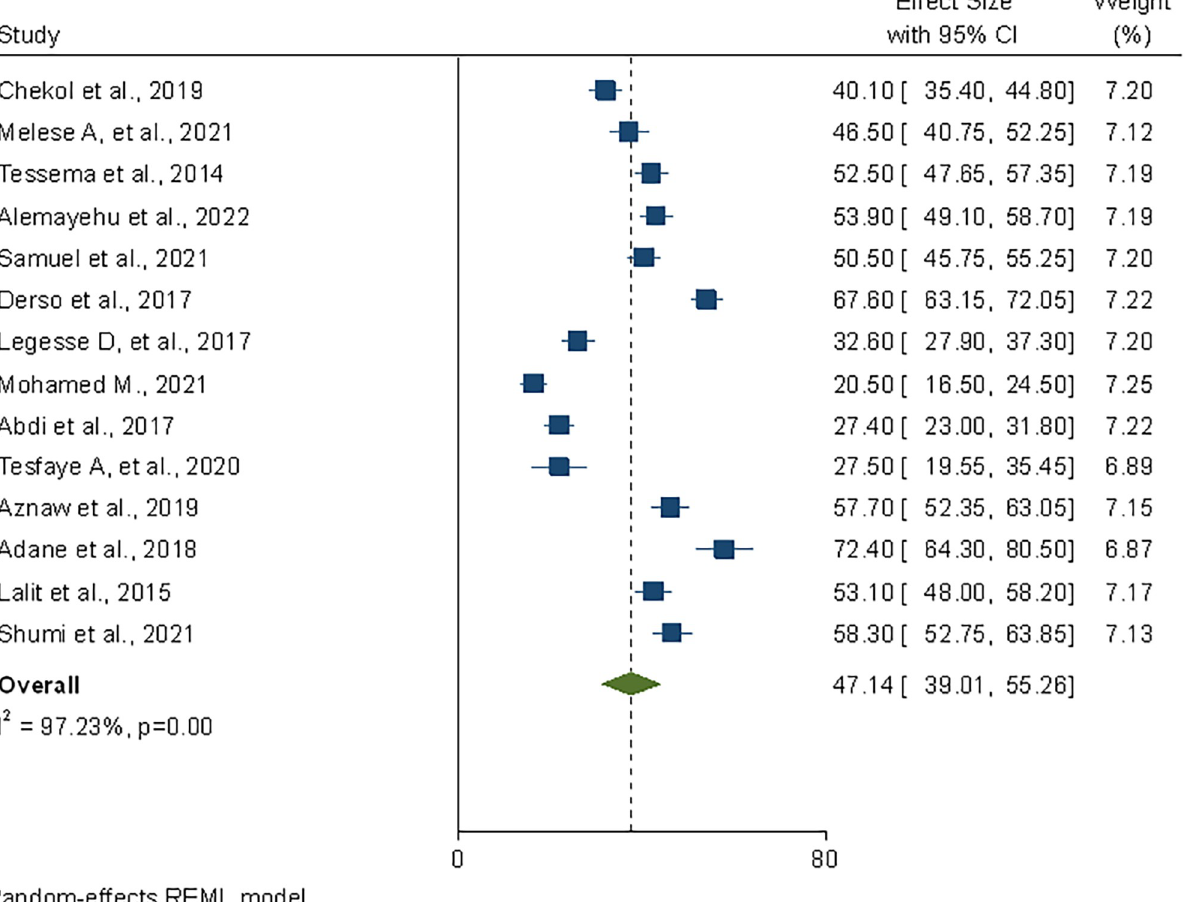
Fig 2. Forest plot depicting pooled prevalence estimate of safe food handling practices among food handlers in foodservice establishments of Ethiopia, 2022.